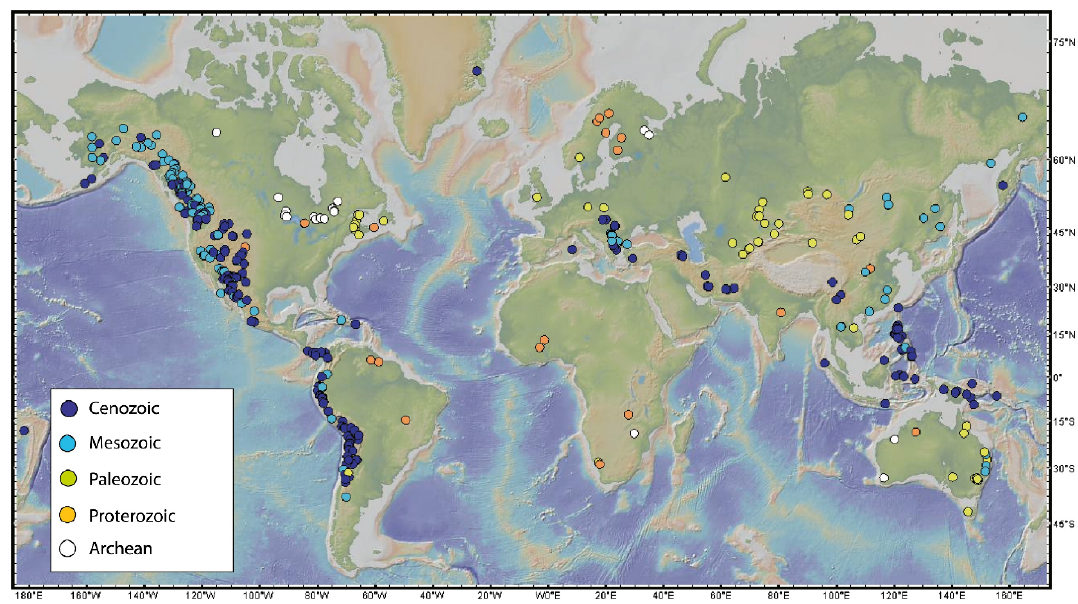
Figure 1. Occurrence of porphyry copper deposits through time (reprinted with permission from Lee and Tang [3], copyright (2020) Elsevier).